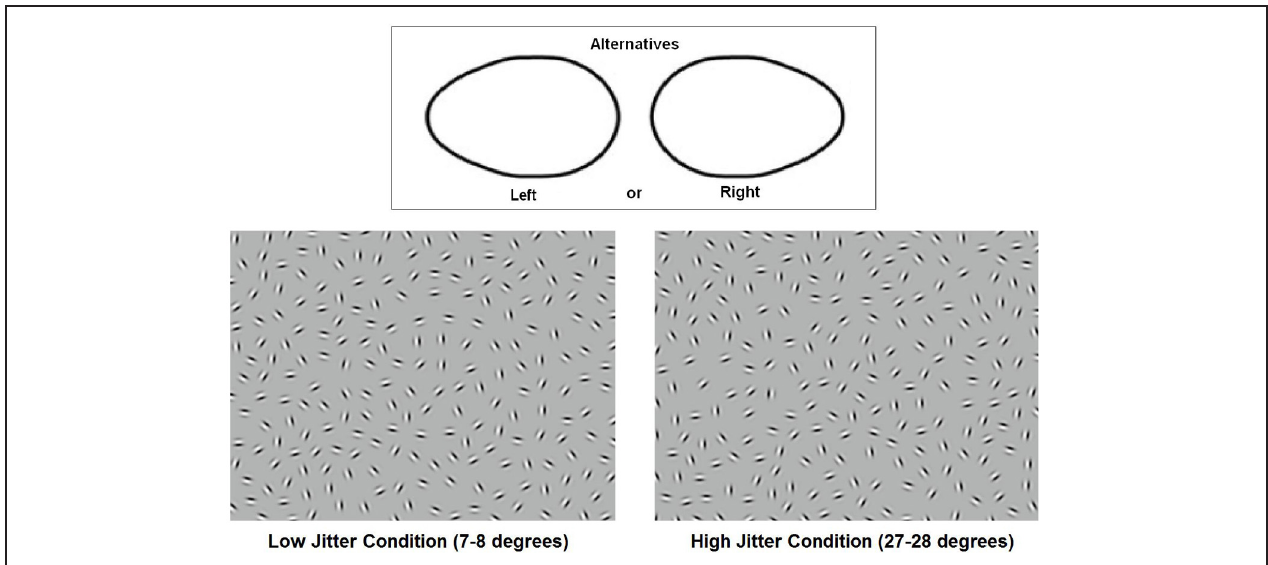
FIGURE 1 | Stimuli. The top panel shows the two basic shapes that the participants discriminated. The bottom two panels show examples of low- and high-jitter